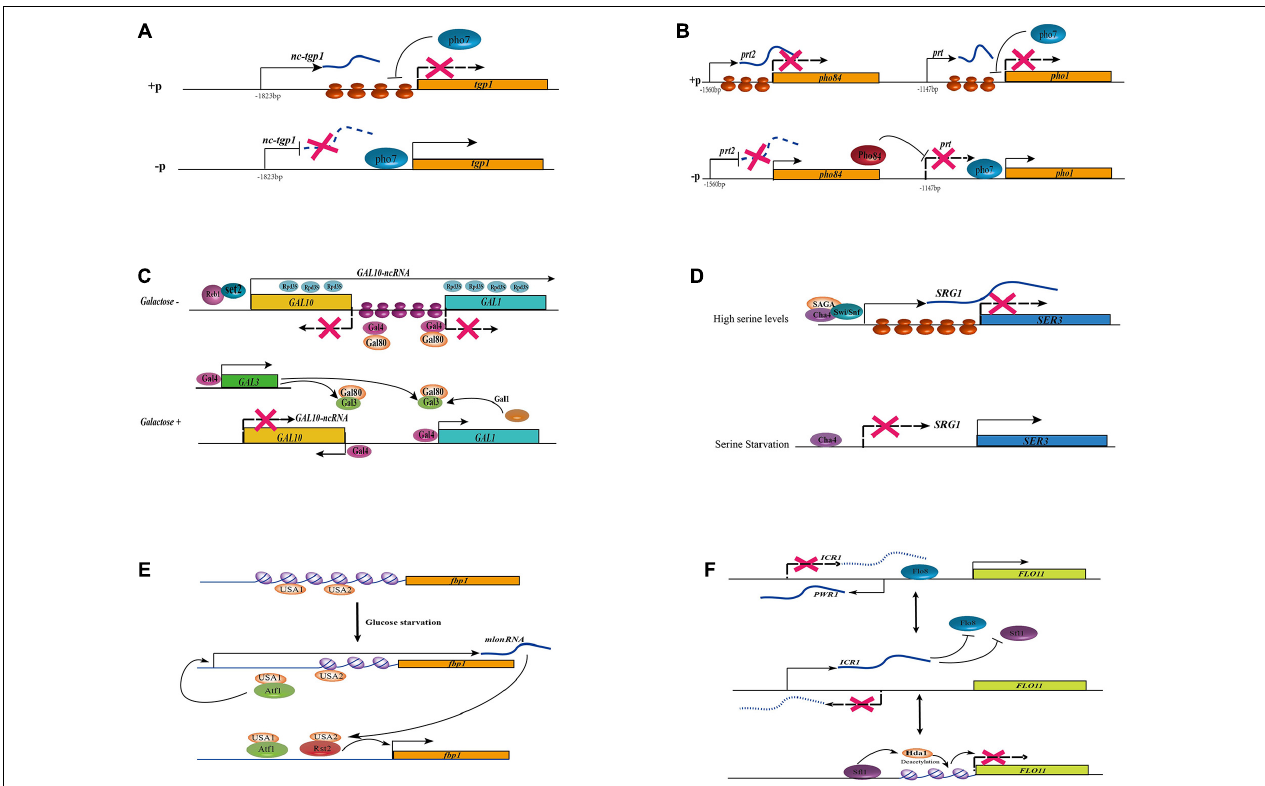
FIGURE 2 | Different regulatory mechanisms of lncRNAs in fungi. (A) In the addition of phosphate, the lncRNA nc-tgp1 initiates at 1,823 nt upstream of the tgp1 mRNA start site. The nucleosome density at the tgp1 promoter is increased with the transcription of nc-tgp1 , which leads to the displacement of Pho7 from the tgp1 promoters, then results in the derepression of tgp1. The transcription of nc-tgp1 is reduced during phosphate deprivation, leading to a decrease in the nucleosome occupancy and expression of tgp1. (B) In the addition of phosphate, the lncRNA prt2 arises from the 1,560 nt upstream of the pho84 mRNA transcription start site. The transcription of lncRNA prt2 blocks the expression of its sense gene pho84 . Similarly, the transcription of lncRNA prt blocks the expression of its sense gene pho1 by increasing nucleosome density at the pho1 promoter and displacing Pho7 from the pho1 promoters, leading to the derepression of pho1 . The expression of lncRNA prt2 is depressed during phosphate starvation, leading to the production of Pho84, which acts as a repressor of prt , finally resulting in the expression of pho1 . (C) lncRNA GAL10- ncRNA regulate the expression of GAL genes. In the absence of galactose, an antisense transcript GAL10- ncRNA that was initiated near the 3’end of GAL10 and terminated in the GAL1 coding region. Transcription of this antisense transcript is dependent on the transcriptional activator Reb1 and Set2 methyltransferase and histone deacetylation activities in cis , thus resulting in silencing of the whole GAL locus. In the absence of galactose, the activity of Gal4 activator is suppressed by Gal80. In the presence of galactose, Gal4 is released, leading to transcriptional activation of the GAL gene by sequestering Gal80 with Gal. Both GAL3 and GAL1 genes can be activated by Gal4 activator, thus forming two positive feedback loops and leading to stable Gal4 release. (D) The transcription of lncRNA SRG1 represses the adjacent SER3 gene under serine-rich conditions. When serine is available to the cells, SRG1 transcription is turned on via a serine-dependent activator Cha4, a coactivator complex SAGA and the ATPase subunit of the Swi/Snf chromatin remodeling complex, leading to the